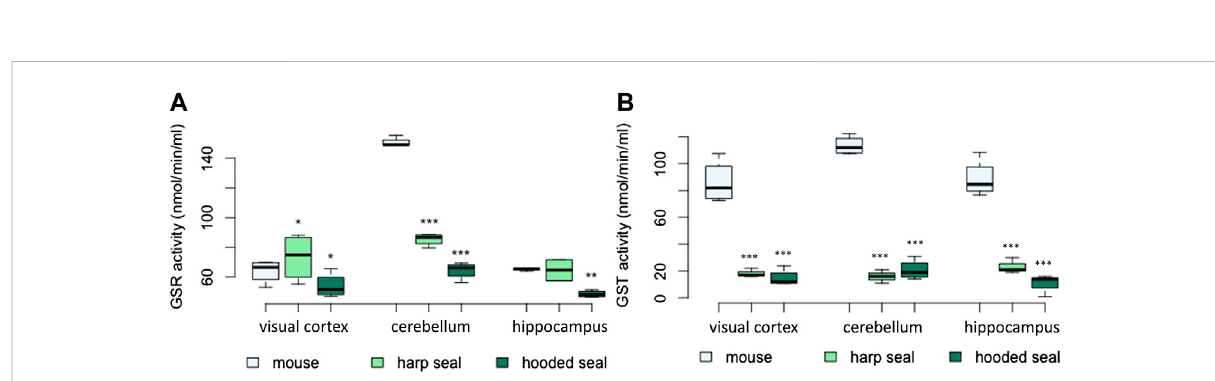
FIGURE 4 (A) Glutathione-disul fi de reductase (GSR) activity (nmol/min/ml) and (B) glutathione-S-transferase (GST) activity (nmol/min/ml) in mice,